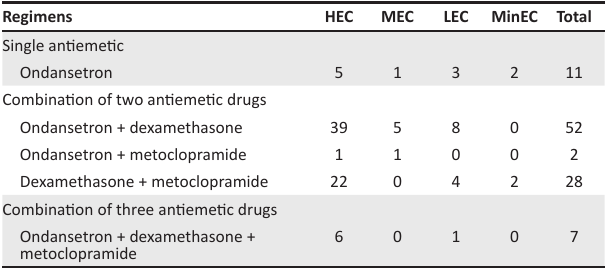
on treatment. This should be achievable in the majority of patients receiving chemotherapy, even with highly emetic